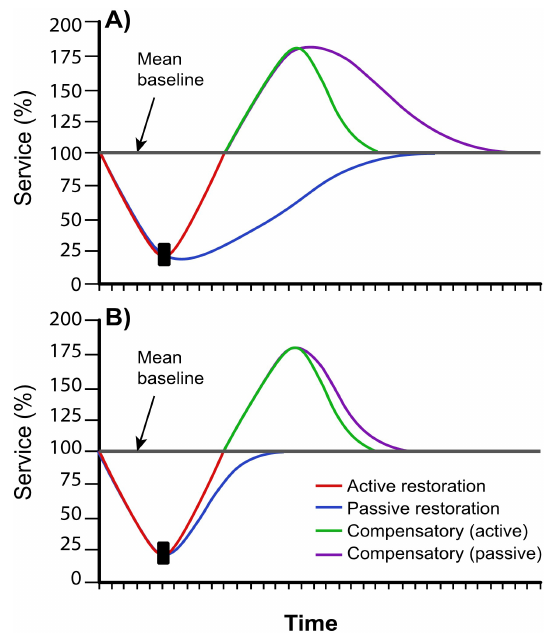
Fig. 1 . Scenarios where human-assisted or active restoration (red line) is (A) and is not (B) more cost-effective than passive restoration (blue line), where the stressor or its adverse effects are removed or mitigated (rectangle) but the system is monitored until it recovers naturally to the mean baseline level of ecosystem services. Also shown is compensatory restoration for the active (green line) and passive restoration (purple line) scenarios. Compensatory restoration, which is required only in some countries, requires the party responsible for the damage to compensate the public for the time and magnitude of the lost ecosystem services. Note how the compensatory restoration is a mirror image (relative to the baseline) of the active and passive restoration but is later in time. Compensatory restoration can begin at any time after the damage has begun (i.e., before or after the active or passive restoration is complete) and often entails improving the services offered by natural resources at ecosystems near the damaged site (off-site restoration). Although the figure is drawn as if the same result will eventually be achieved regardless of the methods, this is not always